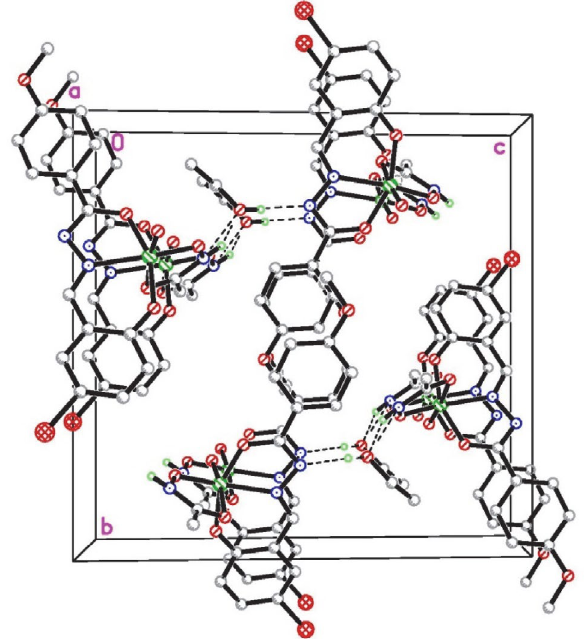
Figure 3. Hydrogen bonds linked structures of complex 1 .